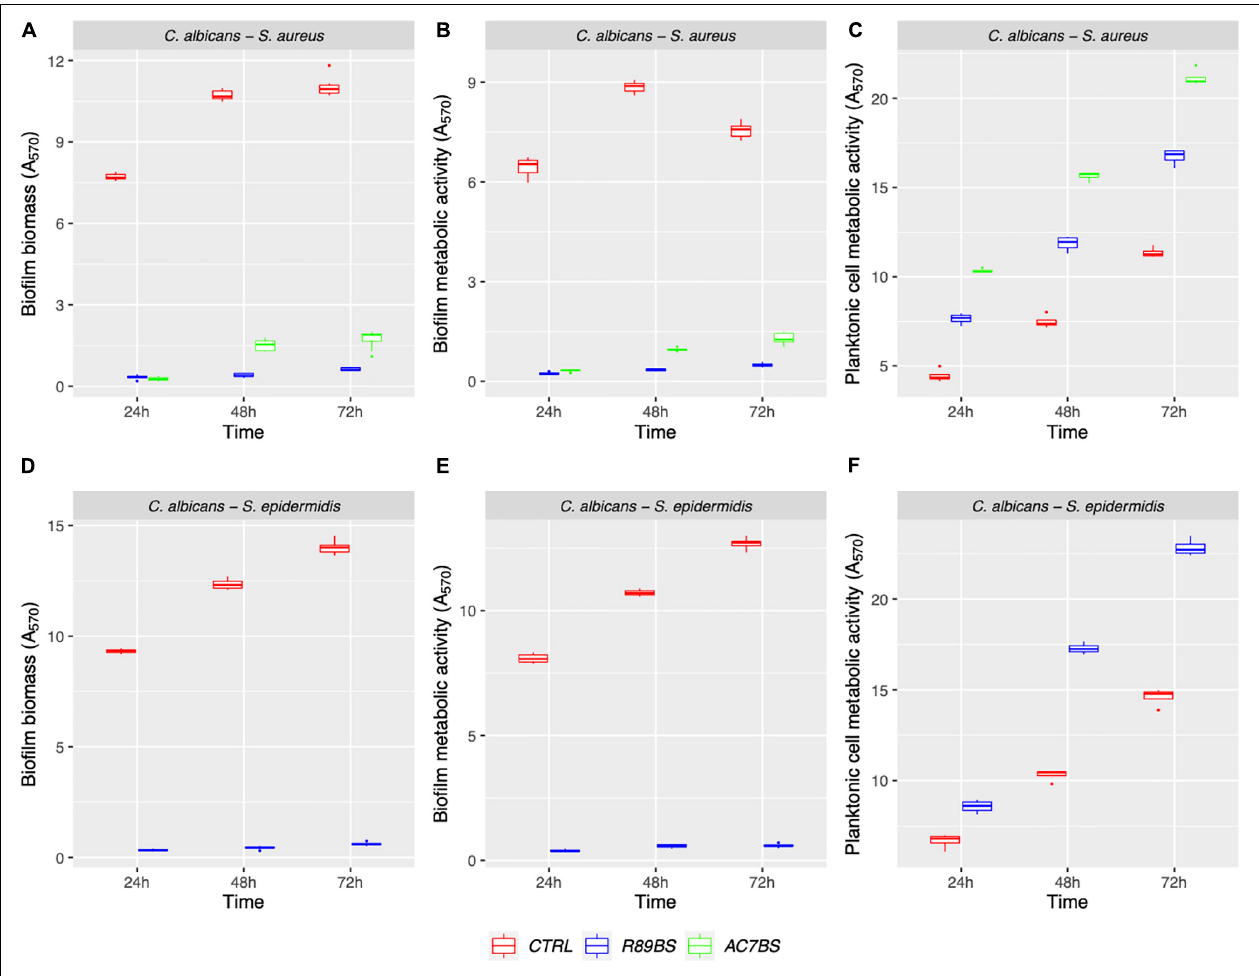
FIGURE 4 | Anti-biofilm activity of BSs in soluble form on C. albicans – S. aureus and C. albicans – S. epidermidis biofilm formation. The anti-biofilm activity of BSs was evaluated in co-incubation conditions in terms of biofilm biomass (A,D) and biofilm metabolic activity (B,E) . The viability of planktonic cells (C,F) was measured by the metabolic activity